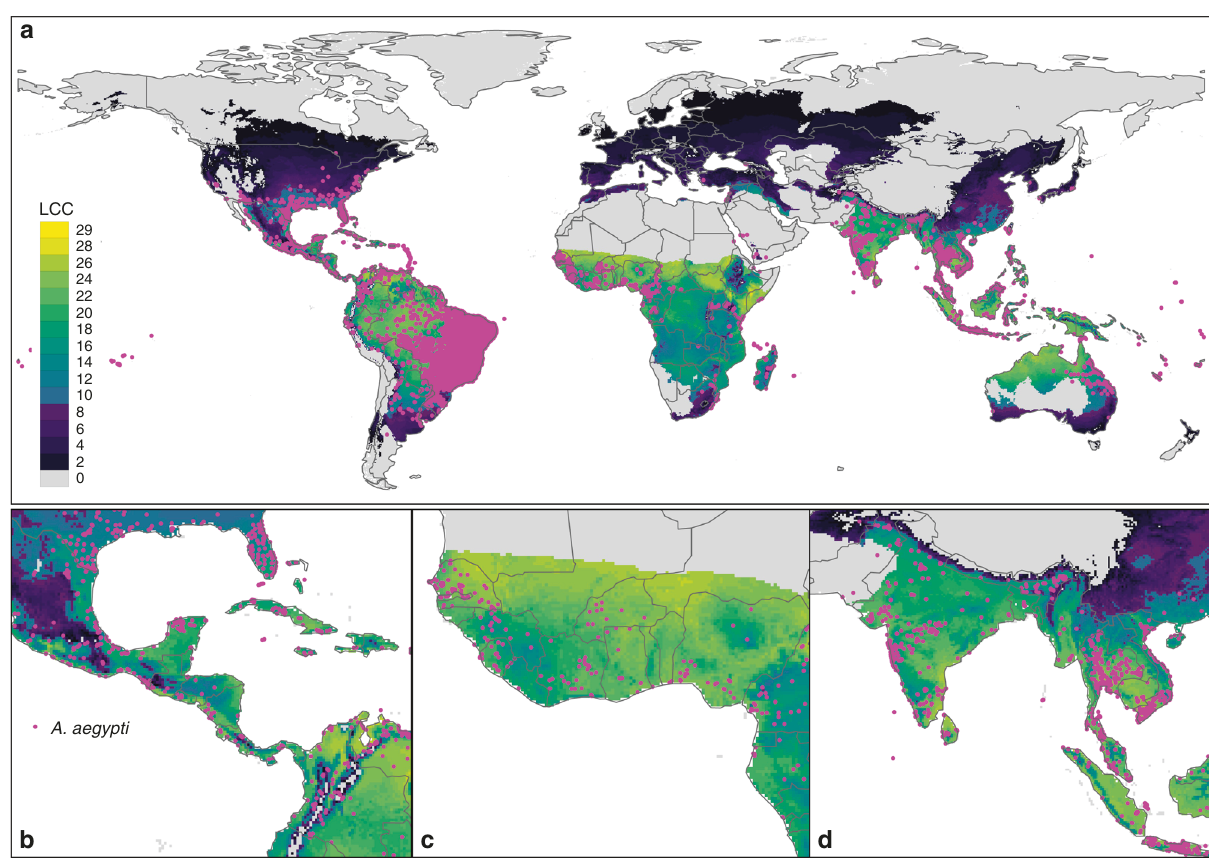
Fig. 1 Distribution of annual LCC of Ae. aegypti with occurrence data overlaid. Maps indicate the total number of LCC per year at the global scale ( a ), Central America ( b ), West Africa ( c ) and South East Asia ( d ). Colour represents the number of LCC. Areas in which LCC < 10, corresponding to the threshold used in subsequent analysis (i.e. Fig. 4), are shown with a darker palette (indigo-black, note legend). Grey colour represents unsuitable areas for Ae. aegypti development. Magenta dots represent presence records of Ae. aegypti (refs. 49,84